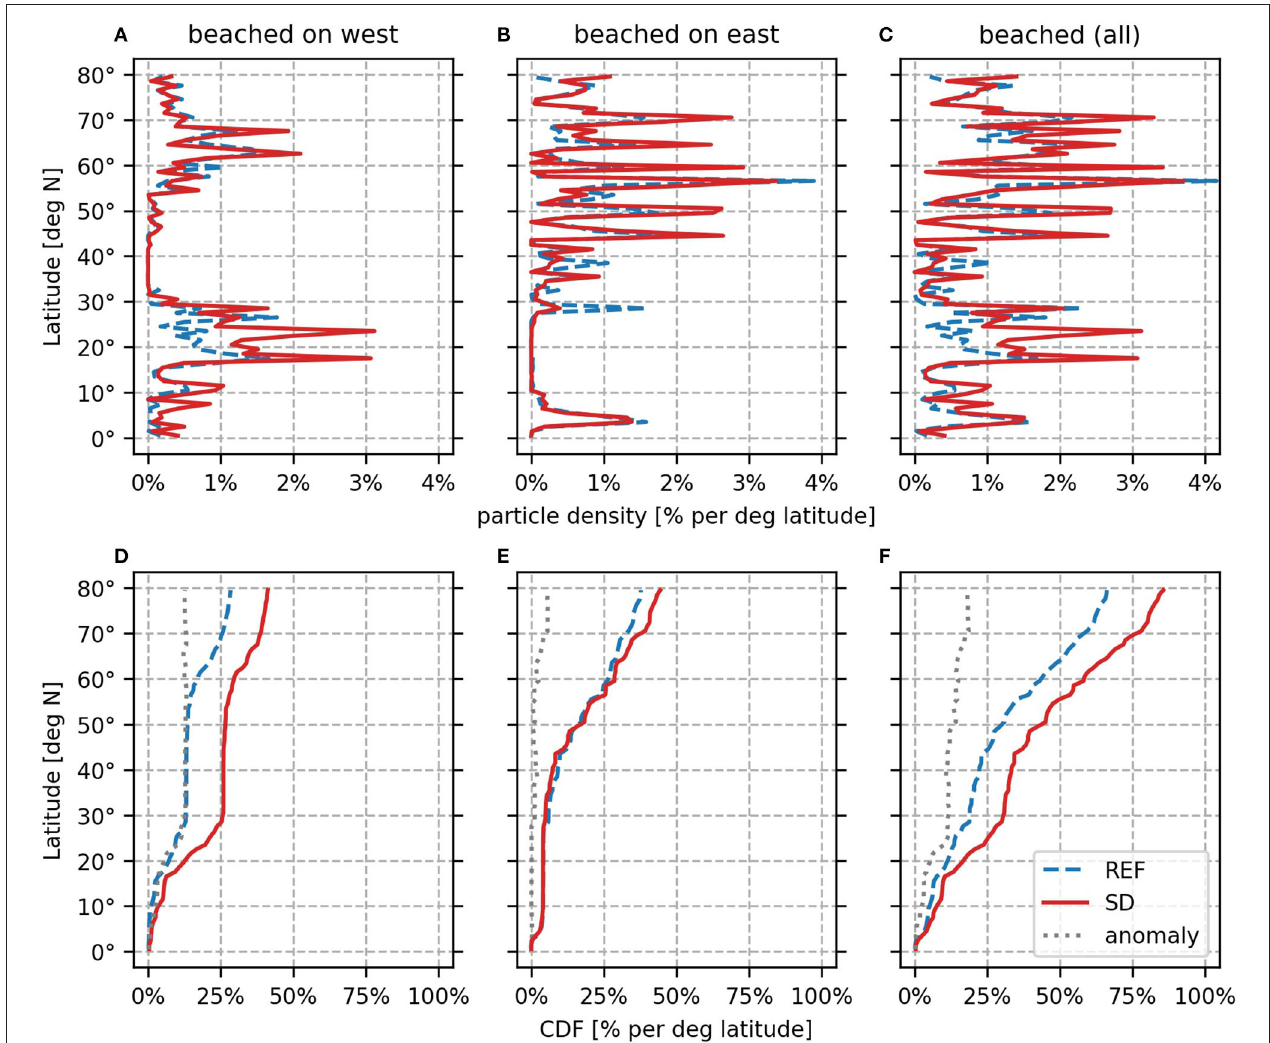
FIGURE 5 | The top panels show the meridional distribution of beached particles at the end of the run on the western side of the domain (A) , on the eastern side (B) , as well as for all beached particles (C) . Data points are in 1 ◦ bins and result from a sum in the longitudinal direction. The bottom panels depict the cumulative distribution function (or “CDF”) obtained by integrating the particle distribution from South to North. This is shown for particles beached on either side of the domain (D,E) and for all beached particles (F) . Percentages are calculated out of the total number of particles